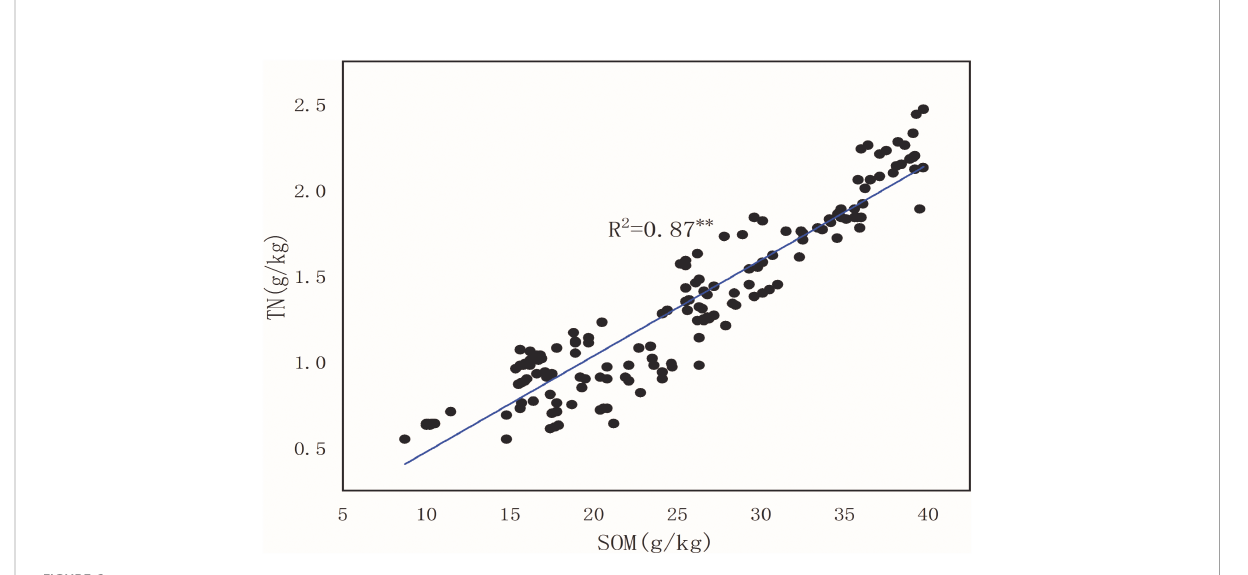
FIGURE 6 Soil organic matter ( x ) and soil total nitrogen ( y )